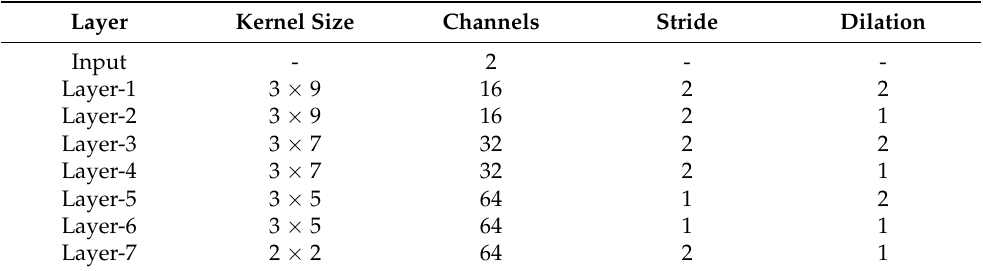
Table 1. Architecture of the feature encoder. The filter’s size decreases as the depth of the network